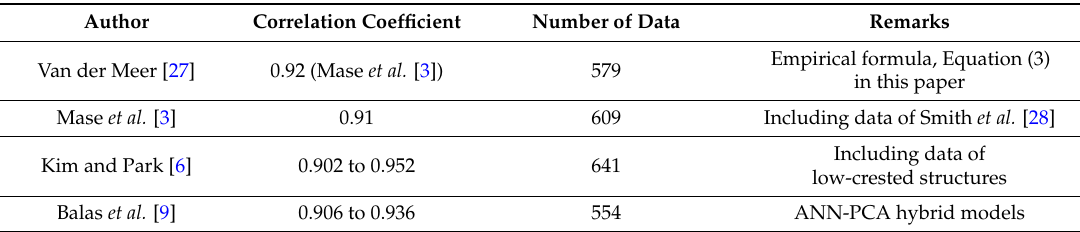
Table 1. Correlation coefficients of different empirical formula or ANN